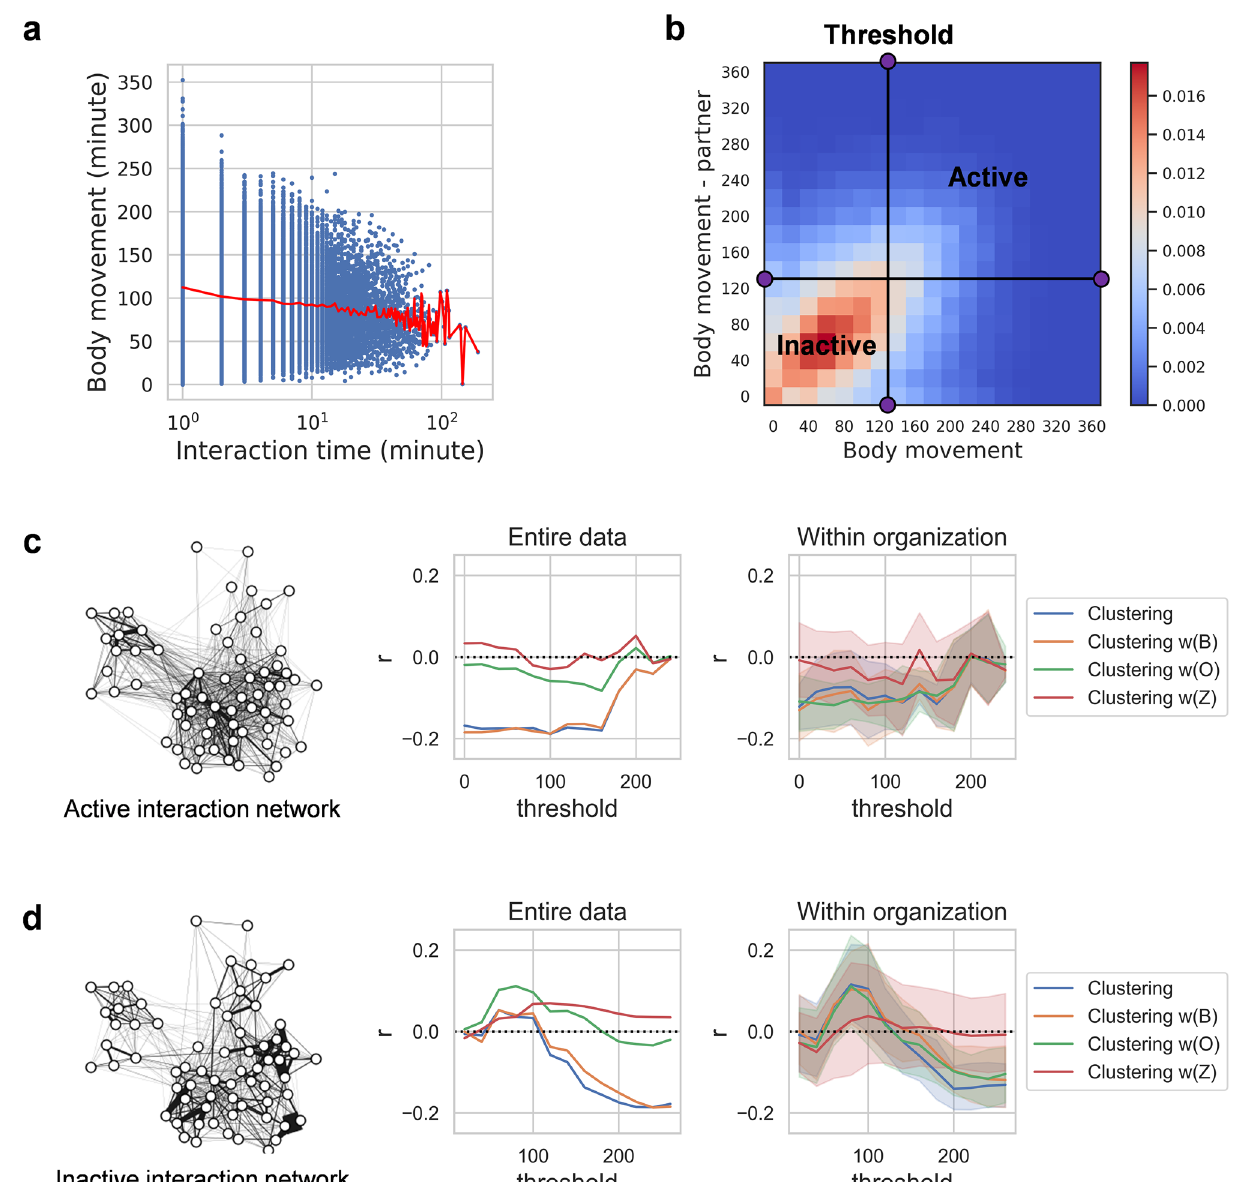
Figure 4. Importance of active and inactive interactions in the relationship between clustering and depressive symptoms. ( a ) The graph shows the relationship between the interaction time and the average body movement of the people who participated in the interaction. The red line is the average body movement for each interaction time, and it shows that the average body movement of people tended to decrease as the interaction time increased. ( b ) The average body movement distribution of individuals and counterparts in all interactions. The colour indicates the density of the interactions. For a specific body movement threshold, if both individuals show a high level of movement, it is an active interaction, and if both show low-level movement, it is an inactive interaction. ( c ), ( d ), The figures on the left side of ( c ) and ( d ) show the structural differences between active and inactive interaction networks at a threshold of 100. Changing the threshold caused changes in the Pearson’s correlation between clustering coefficients and depression scores in the network composed of active interaction ( c ) and network composed of inactive interaction ( d ). The figure on the middle shows the correlation for the entire dataset, and the figure on the right shows the correlation within each organization (band means 95% confidence interval of 1000 bootstrap